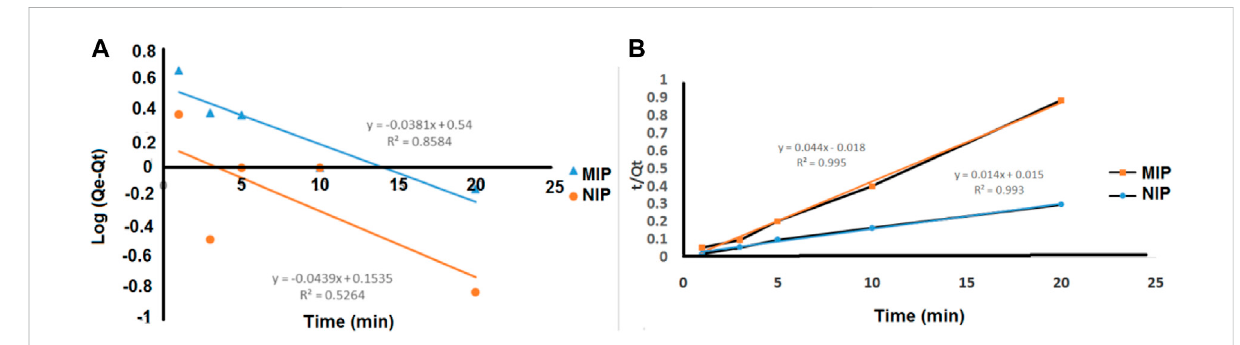
FIGURE 5 (A) Pseudo- fi rst-order and (B) pseudo-second-order kinetic models for the adsorption of quetiapine on the MIP and